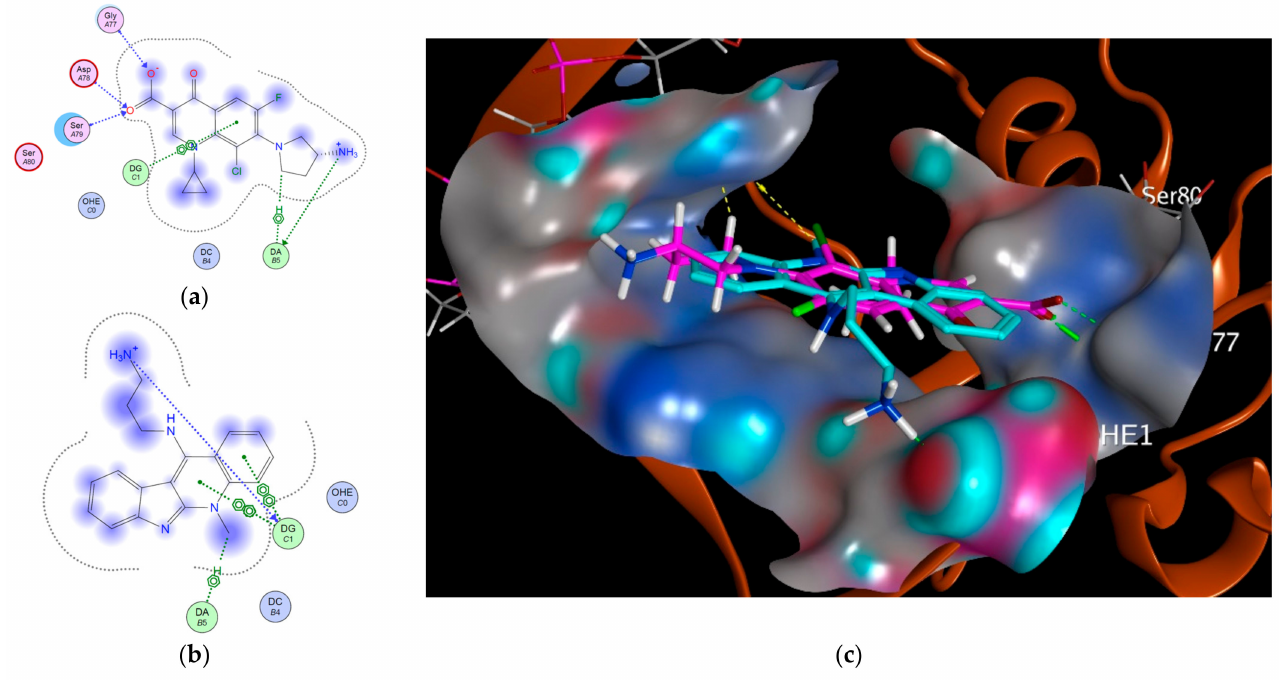
Figure 3. Docking of APAN at the target protein pdb:2AZ5; ( a ) 2D interaction and chemical bonding; ( b ) surface view for APAN complexed with the co-crystalized ligand at the site of interaction.